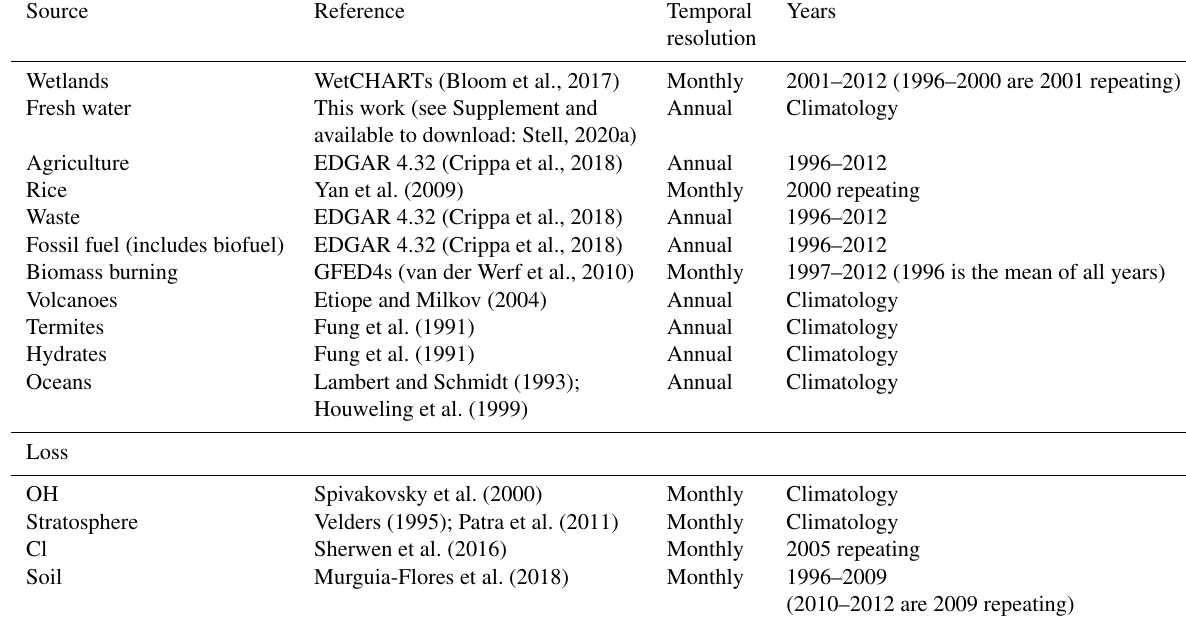
Table 1. The emission and loss field input to MOZART, their literature sources, their temporal resolution, and the years covered by the